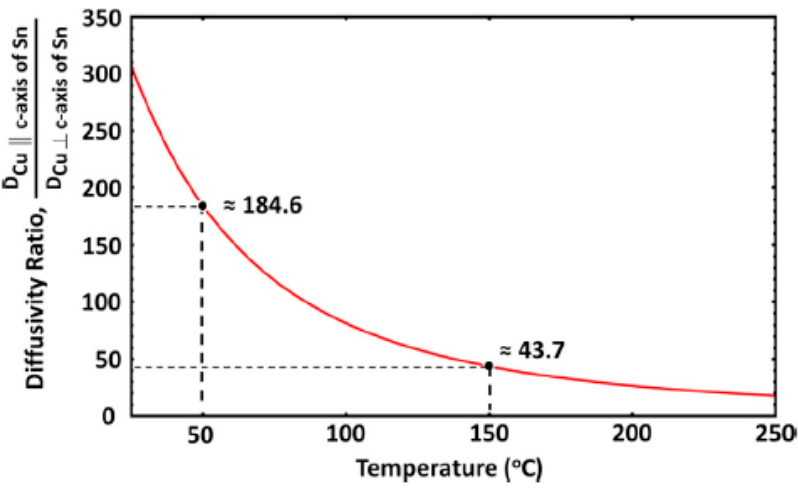
Figure 7. Diffusivity ratio of Cu atoms, along with the c- and a-axis of Sn at various temperatures Reprinted with permission from Ref. [41] Copyright 2015 Elsevier. Table 1. Diffusivities of Ag, Cu, Ni, and Sn in the β -Sn matrix